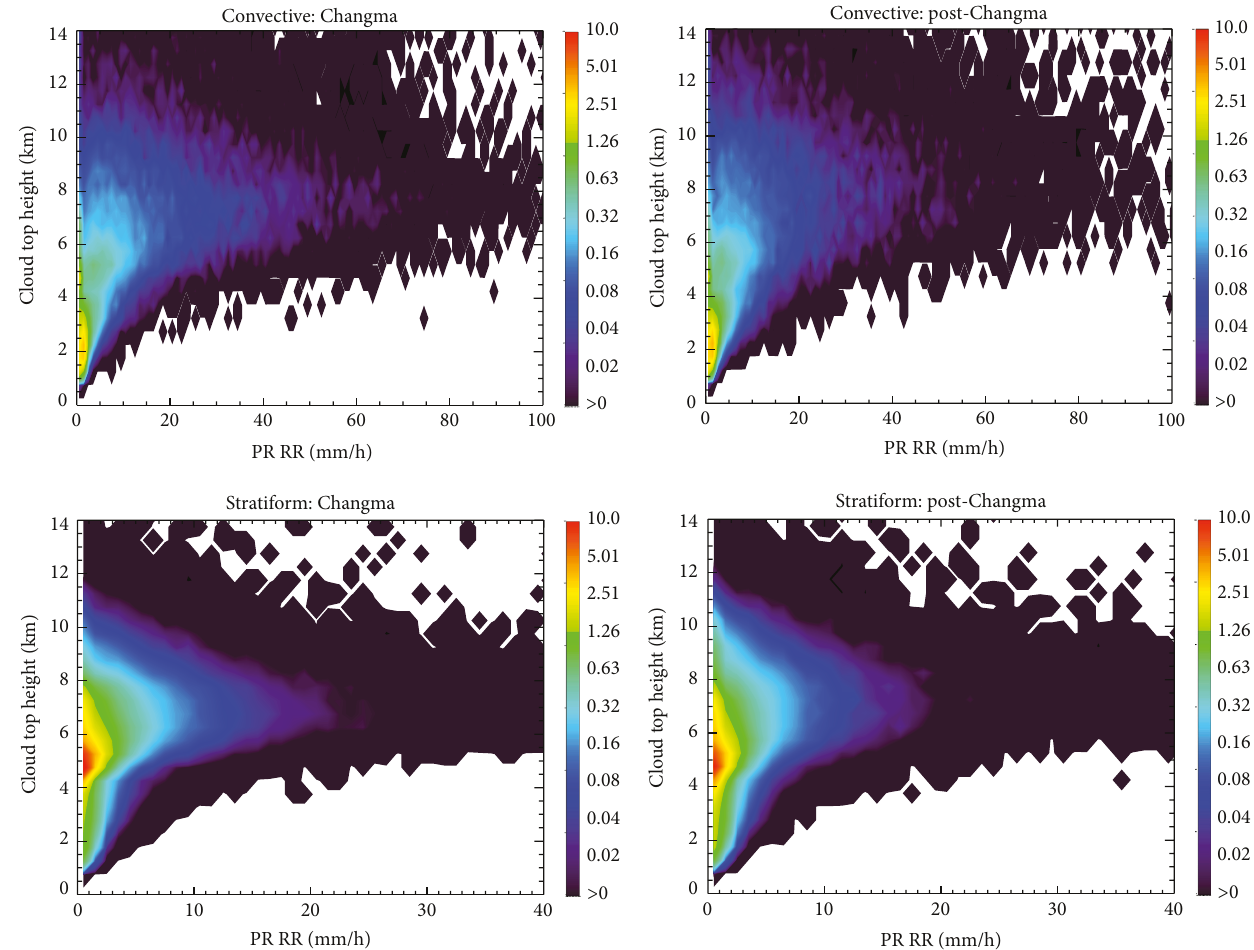
Figure 5: Relative frequency distribution of occurrences (%) as a function of PR rain rate and cloud top height.